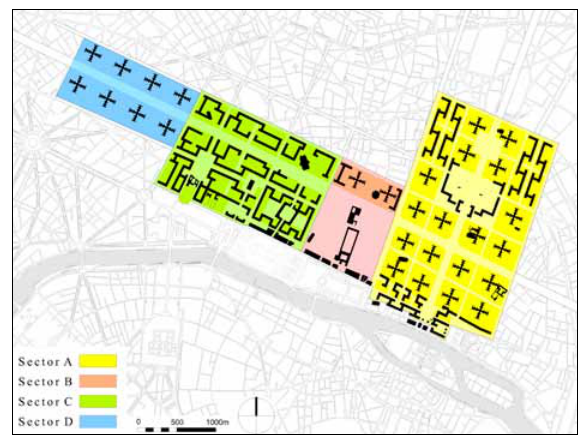
fig. 6. Sectors of Plan Voisin